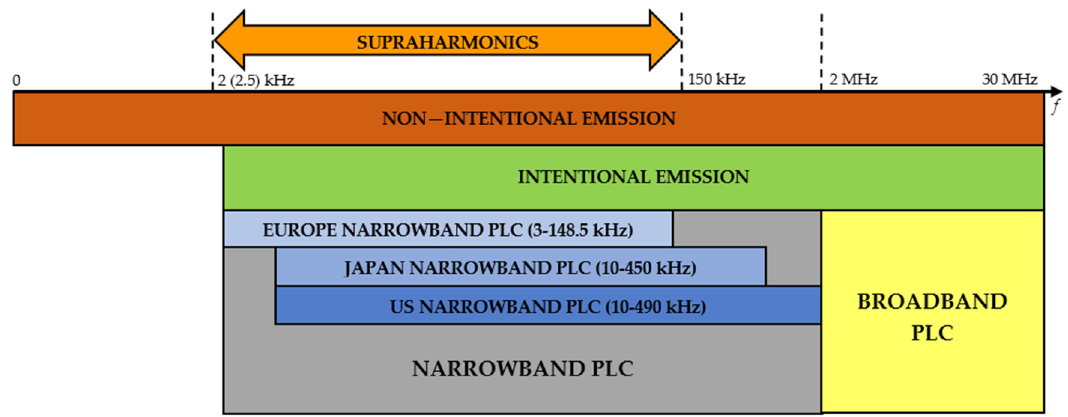
Figure 5. Frequency ranges dedicated to intentional emissions provided by PLC systems.